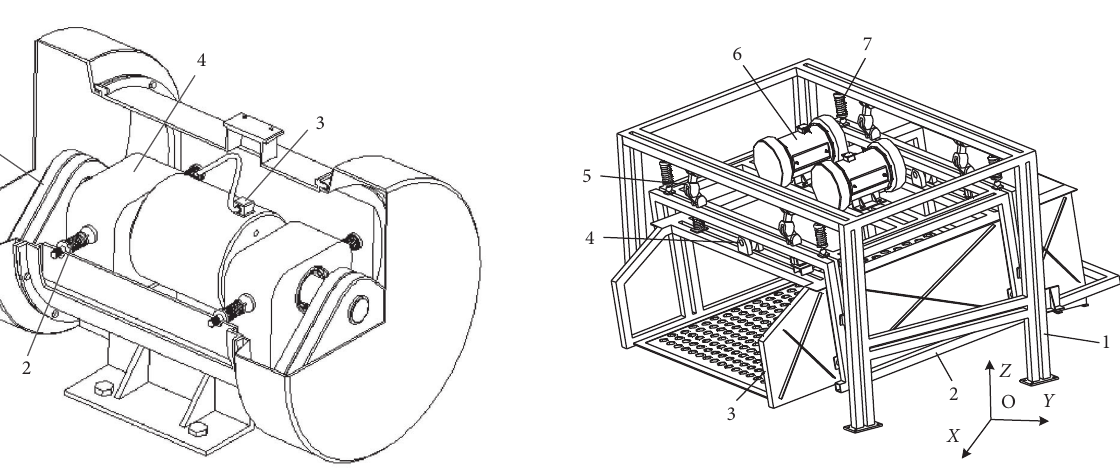
Figure 3: Chaotic exciter. 1: eccentric block; 2: connecting spring; 3: rotary motor; 4: braced seat.